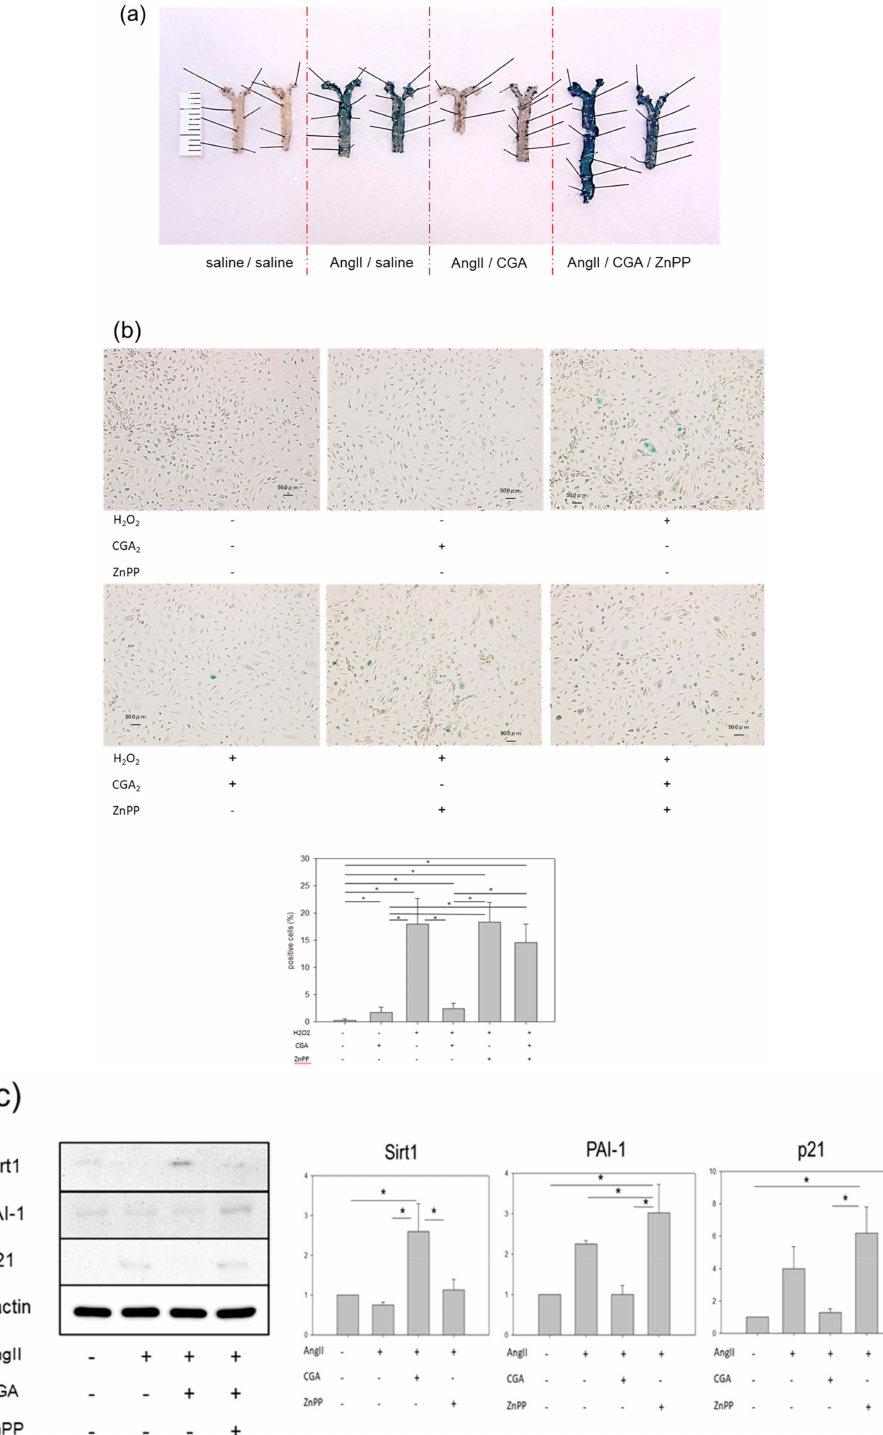
Figure 5. E ff ect of the HO-1 inhibitor on vascular senescence in vivo and in vitro. ( a ) SA- β -gal staining of aorta with or without CGA, and / or i.p. injection of ZnPP, and / or AngII for 14 days; ( b ) SA- β -gal staining of HUVECs co-incubated with or without H 2 O 2 , and / or CGA, and / or ZnPP. The scale bar indicates 50 µ m. Each bar presents the mean ± SE of three experiments ( n = 6) * p < 0.05; ( c ) Protein expression of Sirt1, eNOS, PAI-1, and p21 in aortas. ( n = 3). * p < 0.05. Values represent the means ± SE of three